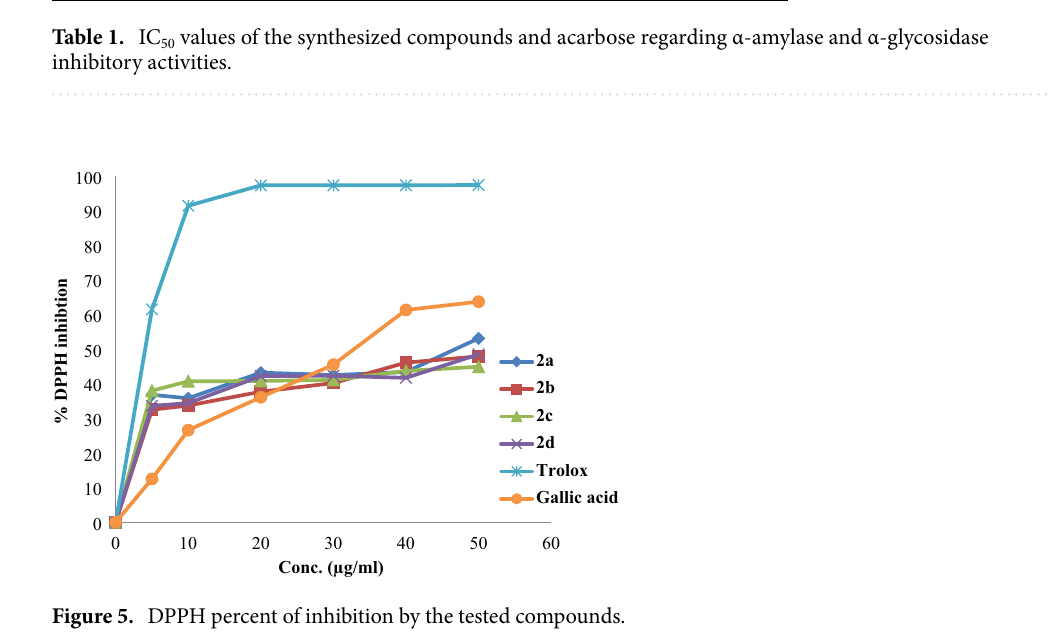
Figure 5. DPPH percent of inhibition by the tested compounds.